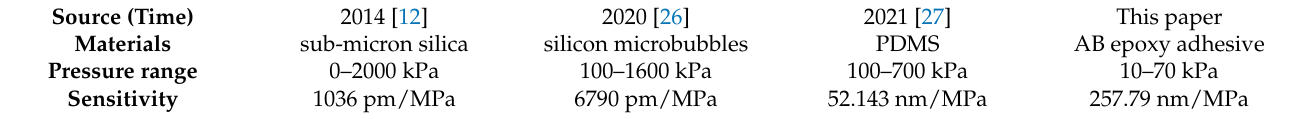
Figure 11. The movement of interference spectra under different humidity conditions. Table 2. The sensitivity of optical fiber Fabry–Perot pressure